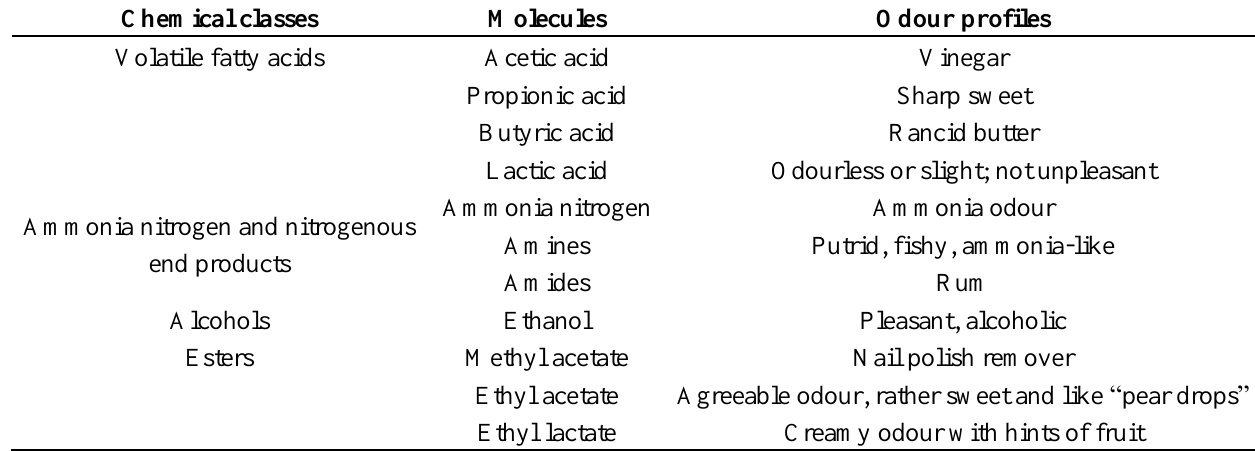
Table 1. Characteristic smells recognised by humans and the principal chemical classes detected in